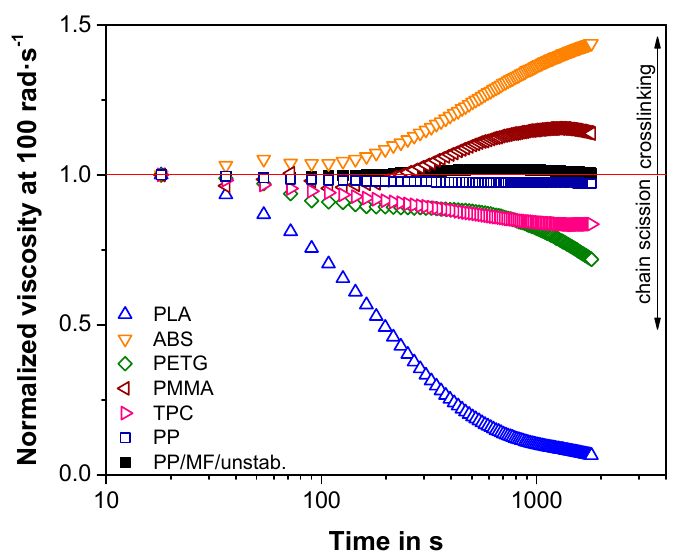
Figure 2. Time sweep rheological measurements for frequently used, commercially available materials for fused filament fabrication (FFF) and for the composite PP / MF / unstab. and its base polymer PP, measured at their suggested nozzle temperature. The red line at a normalized viscosity of 1 represents a visualization of ideal thermal stability. As highlighted, above this line, crosslinking occurs, and below this line, chain scission takes place.